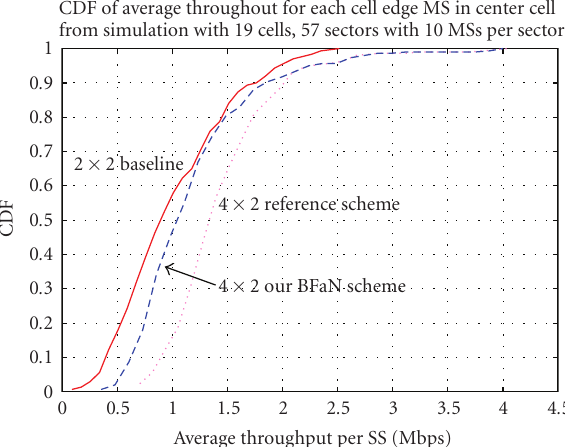
Figure 6: CDF of average MS throughput rate of BFaN.